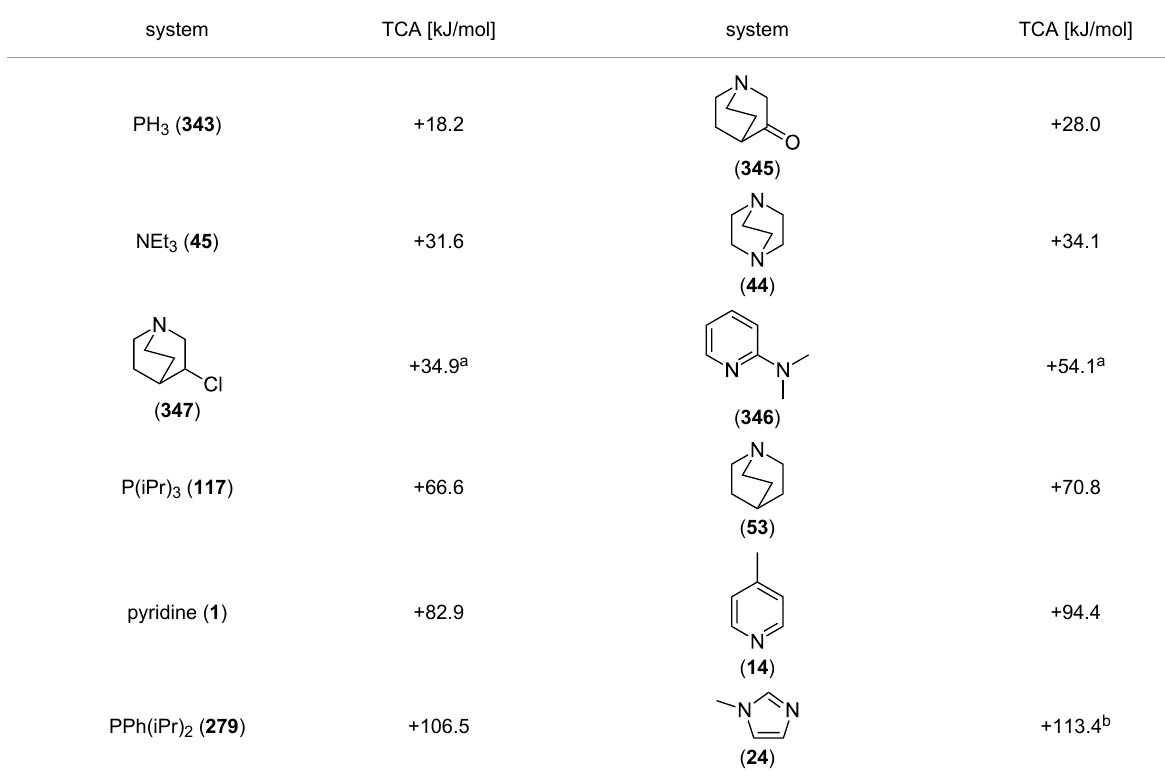
Table 10: TCA values of Lewis bases, ordered by increasing TCA values.